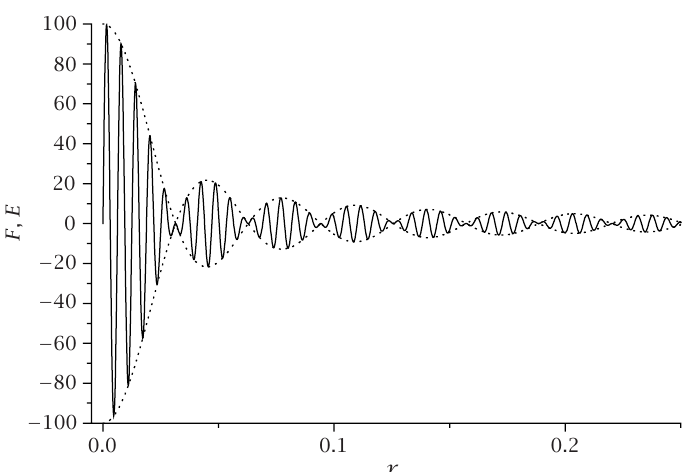
Figure 10.1 . Radial distribution of the envelop solutions F(r) of NDEs (dotted line) and the corresponding real electrical field E(r) (solid line). The real field tends to zero in the